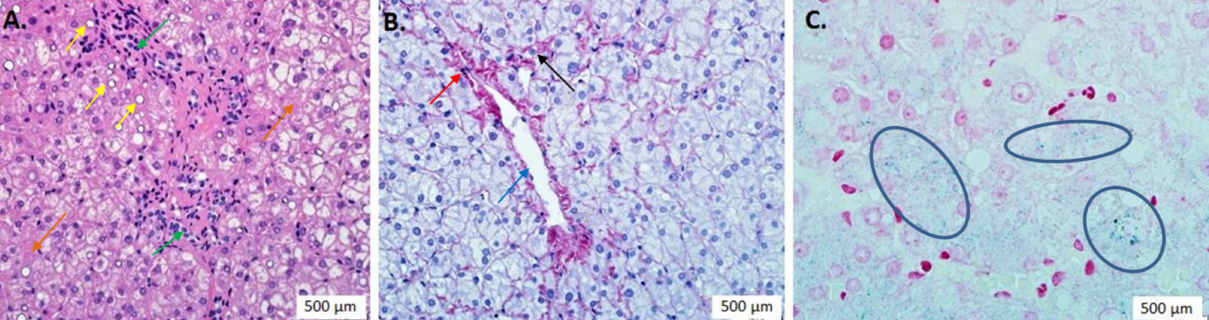
Figure 3. Results of the liver biopsy. ( A ) Hematoxylin and eosin staining. Moderate diffuse mi- crovesicular steatosis (++, indicated by yellow arrows), parenchymatous bilirubinostasis (indicated by orange arrows) and cholangiopathy with proliferation of small ducts (indicated by green arrows). ( B ) Van Gieson staining. Dilation and full-blooded centrilobular sinusoids (indicated by red arrow), moderate central vein wall sclerosis (indicated by blue arrow) and capillarization of adjacent sinu- soids (indicated by black arrow). ( C ) Perles staining. Initial signs of hemosiderin accumulation in liver tissue (in blue ovals) — hemosiderosis (+). The number of pluses reflects the intensity of the